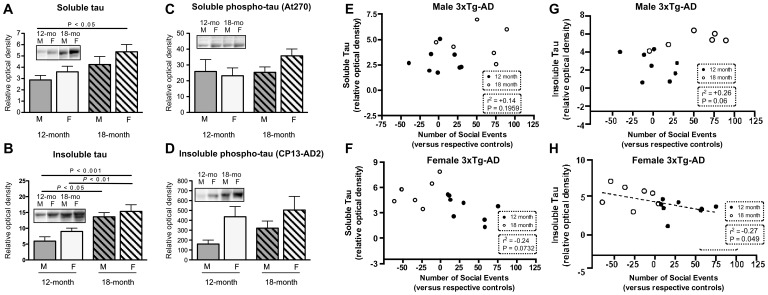
Age-dependent accumulation of tau protein in soluble and insoluble protein fractions in 3xTg-AD mice.Western immunoblots showing tau accumulation with age as quantified in the TBS-soluble (soluble proteins) and the formic acid-soluble (insoluble proteins) fractions from the frontal cortex of 3xTg-AD mice. Consistent trends toward increases were seen in female 3xTg-AD mice. (E–H) To evaluate the relation between tau load and social behaviour, the number of social events displayed by 3xTg-AD mice (relative to its NonTg partner) was plotted against soluble tau concentrations in the frontal cortex. A significant correlation could only be established between insoluble tau concentrations and social events in female across the 2 groups of age (dotted lines).